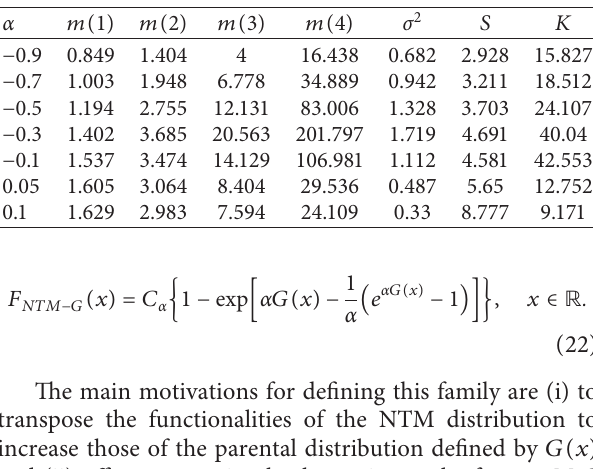
Table 1: Values of moment measures of the NTM distribution for different values of α